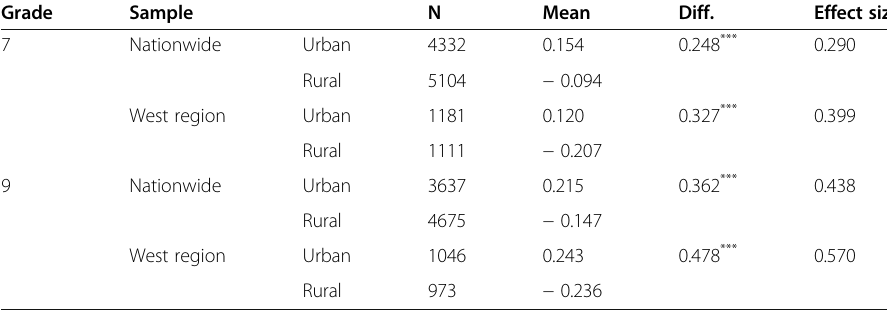
Table 1 Cognitive ability of urban and rural students Grade